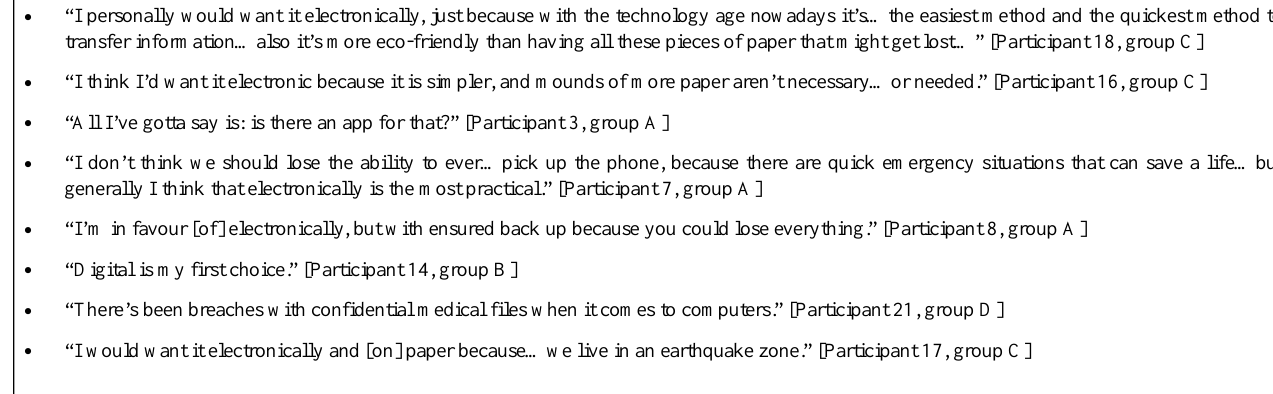
Textbox 3. Participant quotes about electronic information